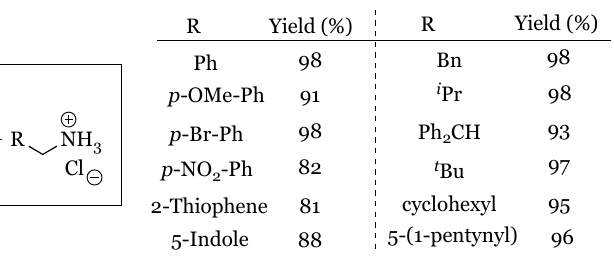
Figure 22. Two-step reduction and deprotection of aryl and alkyl nitriles to their corresponding primary amine hydrochloride salts using diethylsilane and 1 M HCl.